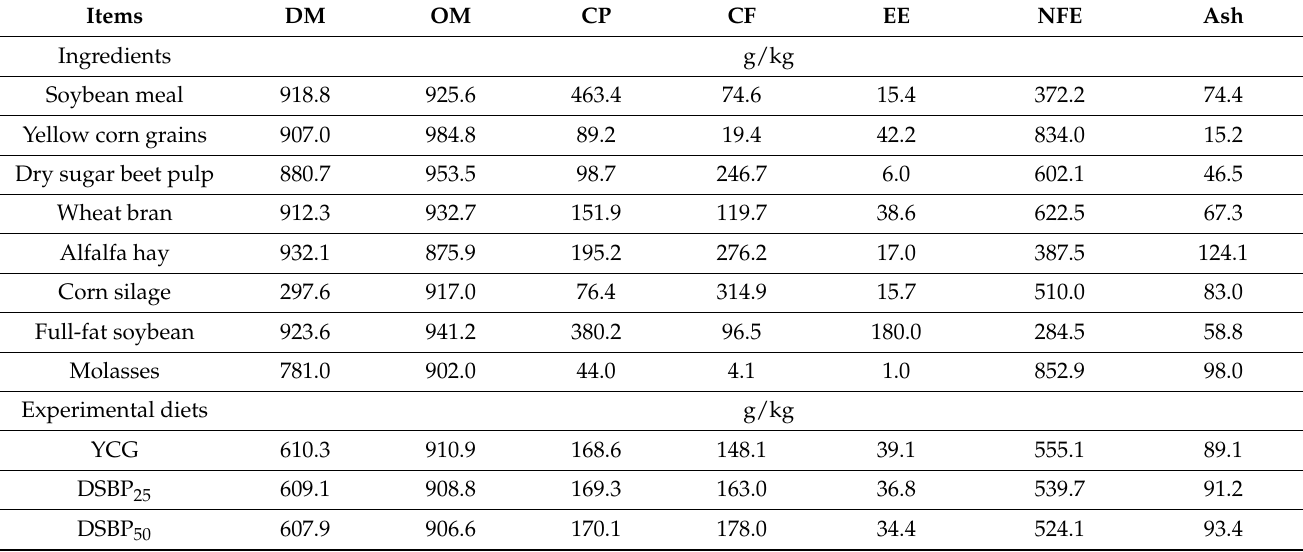
Table 2. Chemical composition of ingredients and experimental diets